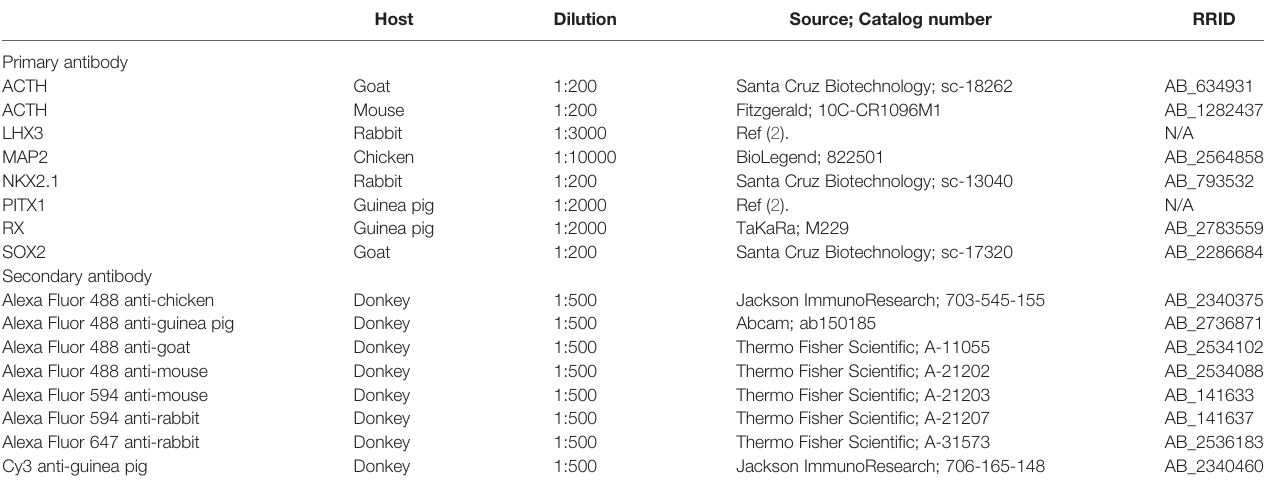
TABLE 1 | Primary and secondary antibodies used for